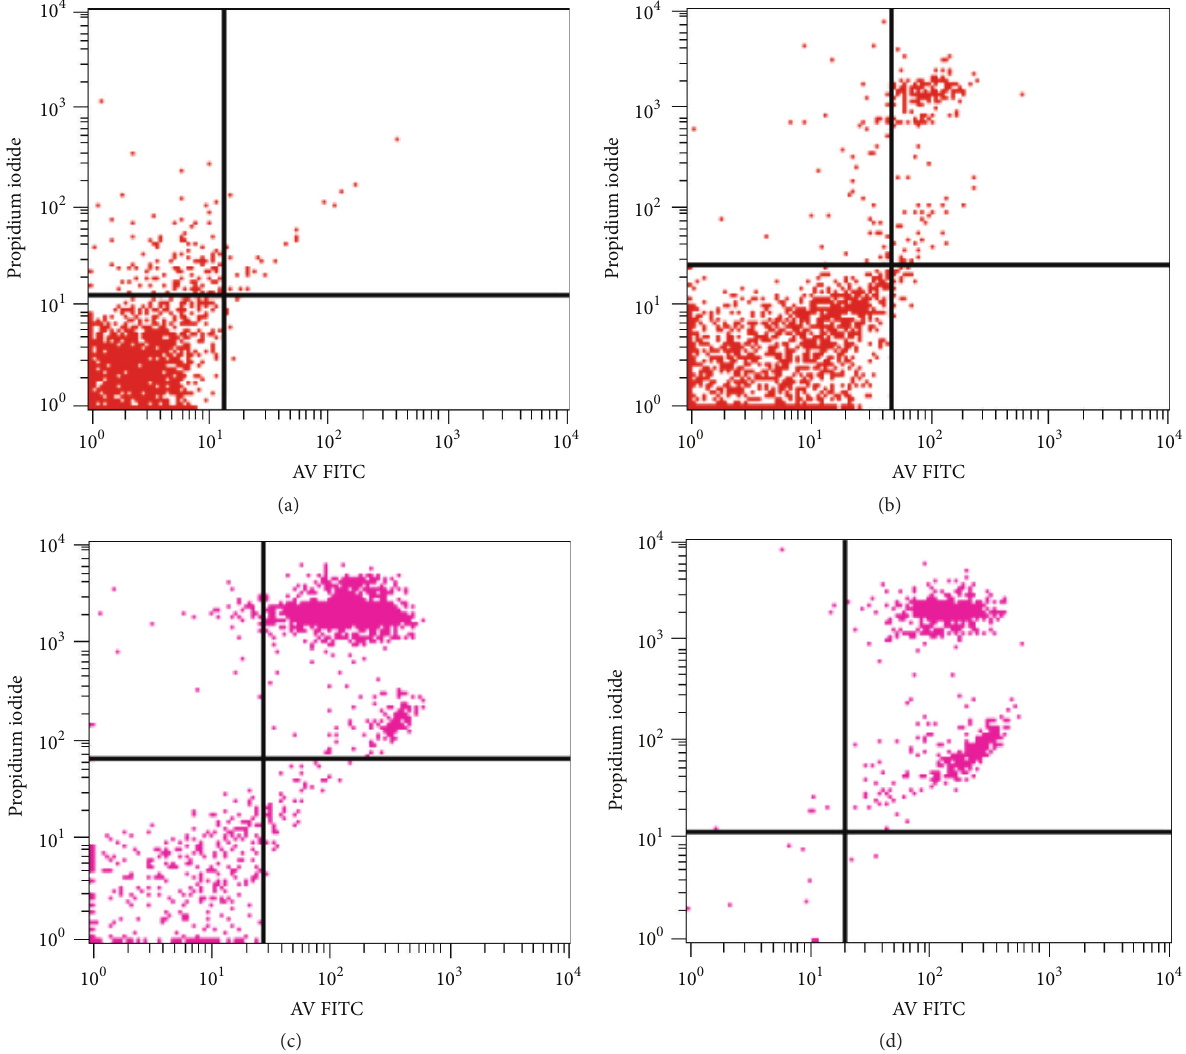
Figure 5: Dot plot of PI/annexin-V FITC-staining of breast cells. (a) Staining using the isotypic control antibody. (b) Staining of untreated breast cancer patient primary tumor cells. (c) Staining of primary breast cancer patient tumor cells after treatment with PTX. (d) Staining of breast cancer patient primary tumor cells with ALG-PTX